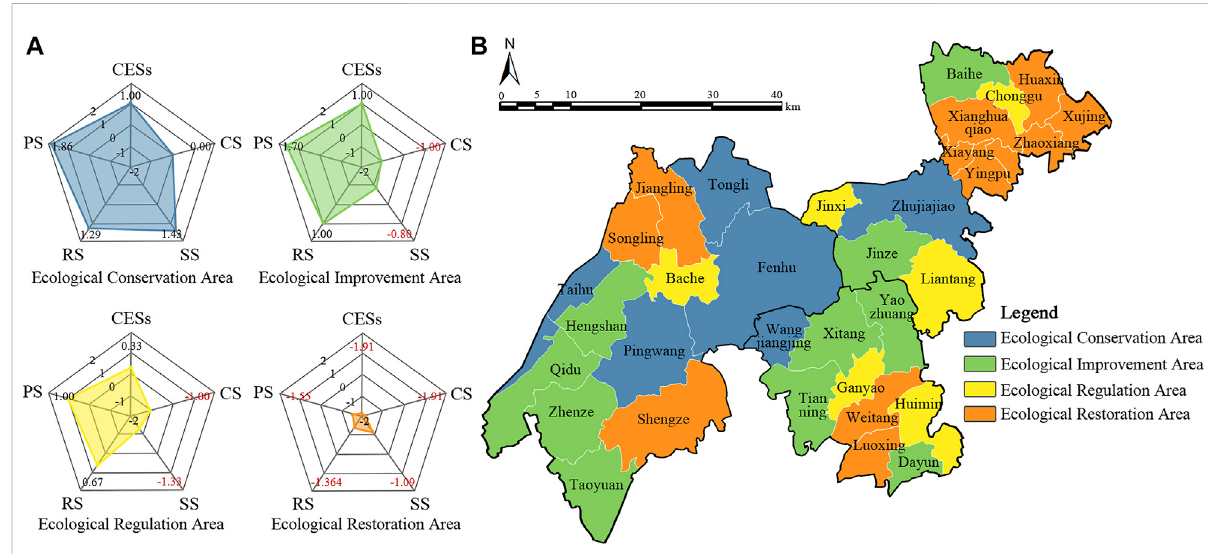
FIGURE 6 Ecologicallandzoninginthestudyarea. (A) CharacteristicsofESsurplusdegreeinfourdivisions. (B)